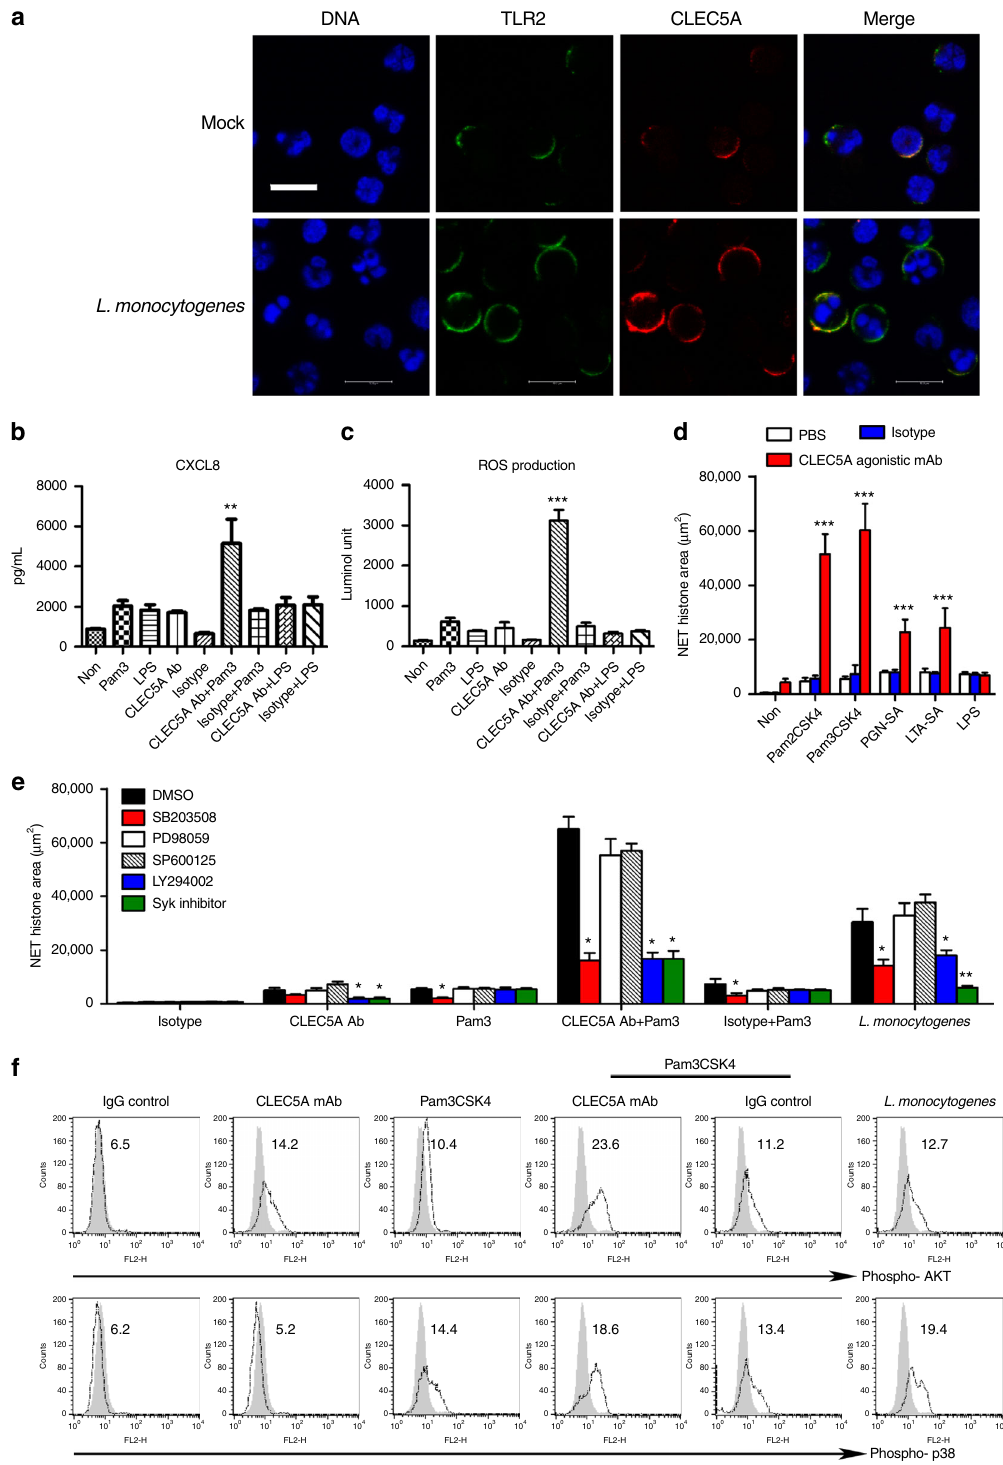
Fig. 6 Coactivation of CLEC5A and TLR2 promotes NET formation via AKT and p38 MAPK. a Human neutrophils were incubated with L. monocytogenes for 60 min, and surface expression of CLEC5A and TLR2 was observed with a confocal microscope. Scale bar , 10 μ m. b , c Human neutrophils were incubated with anti-CLEC5A agonistic mAb (2D8G9) and TLR ligands simultaneously for 2 h beforecollection, and b CXCL-8 production, c ROS production and d NET formation were determined. e Human neutrophils were pretreated with kinase inhibitors: p38 MAPK (10 μ M, SB-203580), ERK (10 μ M, PD-98059), JNK (10 μ M, SP-600125), PI3K (5 μ M, LY-294002), and Syk (10 μ M, Syk inhibitor) for 30 min, followed by incubation with CLEC5A agonistic mAb, Pam3CSK4, or L. monocytogenes . NET was quanti fi ed by measuring histone and was displayed as NET histone area ( μ m 2 )/per fi led. f Intracellular phosphorylated p38 MAPK and AKT kinases were detected by FACS at 30 min post stimulation. Shaded histograms: Isotype control; number: mean fl uorescence intensity. For b – e , the data were collected and expressed as mean ± s.e.m. from four independent experiments. One-way ANOVA was performed. * P < 0.05, ** P < 0.01, *** P < 0.001 for treated versus control groups (isotype or